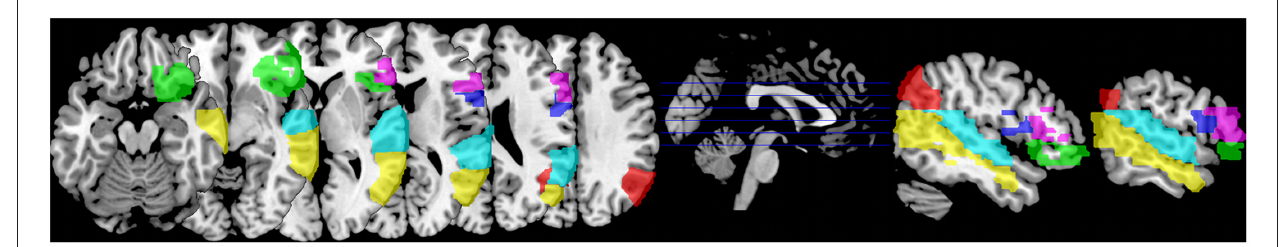
FIGURE 2 | Distribution of regions of interest (ROI; defined as Brodmann areas (BA), only right-hemispheric regions are shown) used in this study located in the inferior frontal gyrus (IFG); BA 44 pars opercularis (dark blue), BA 45 pars triangularis (purple), and BA 47 pars orbitalis (green), and in the temporoparietal region; BA 39 angular gyrus (red), BA 22 superior temporal gyrus (cyan) and BA 21 middle temporal gyrus (yellow).